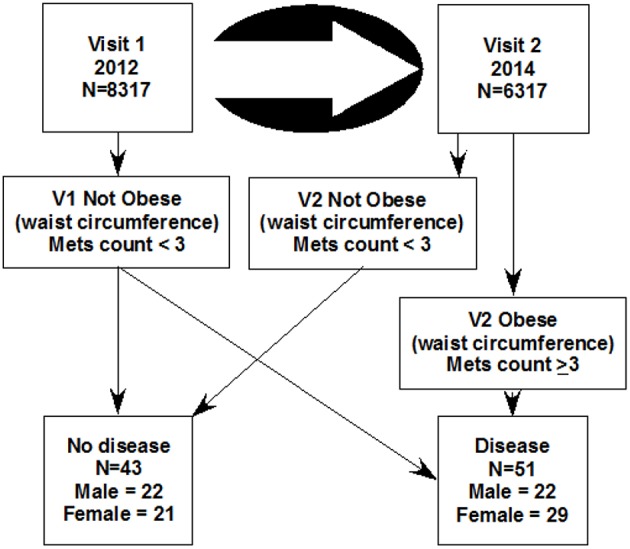
The design of this study which selected 94 children from a longitudinal study of two visits. The metabolic disease category was selected such that 51 were not obese at the first visit and became obese 2 years later at the second visit (the disease group). The 43 control subjects (the healthy group), were selected for not having obesity at either visit. Mets count is the sum of 4 binary metabolomic syndrome characteristics (obesity by waist circumference + high blood pressure + high salivary glucose + low salivary cholesterol).